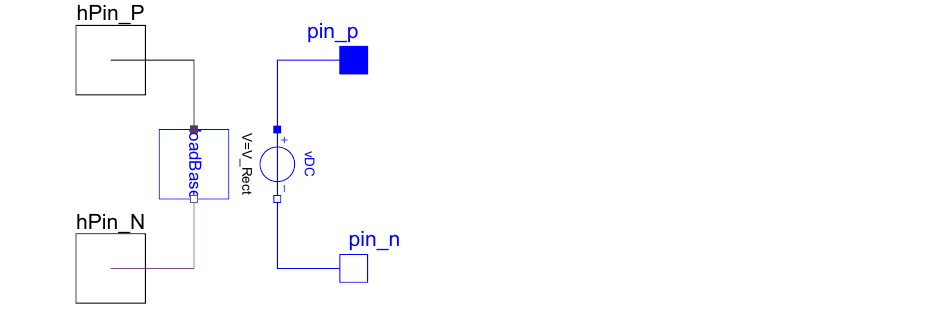
Figure 13. Two-port converter device model underlying